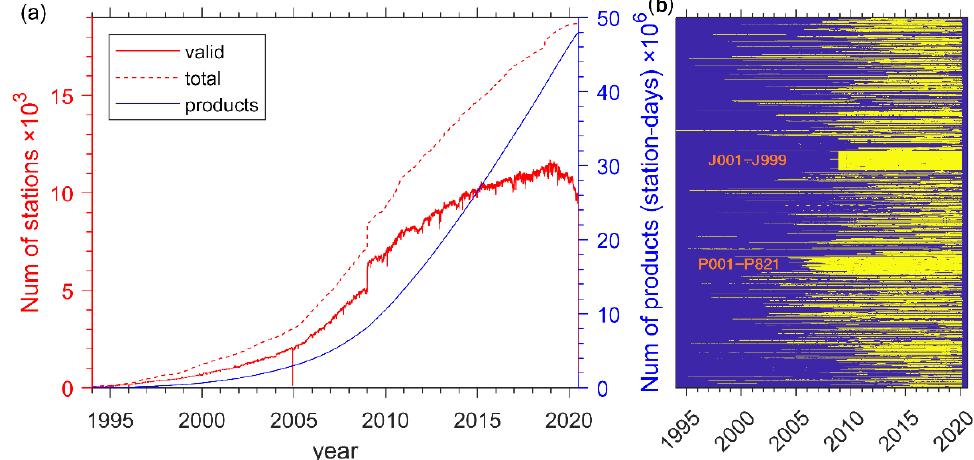
Figure 1. Variability in the numbers of Nevada Geodetic Laboratory (NGL) stations and products. ( a ) The number of valid NGL stations (red solid line), the total number of stations (red dotted line), and the total number of products in the database data (blue solid line); ( b ) the effective time for each station (each yellow horizontal line represents a station, and station names are in alphabetical order from top to bottom).